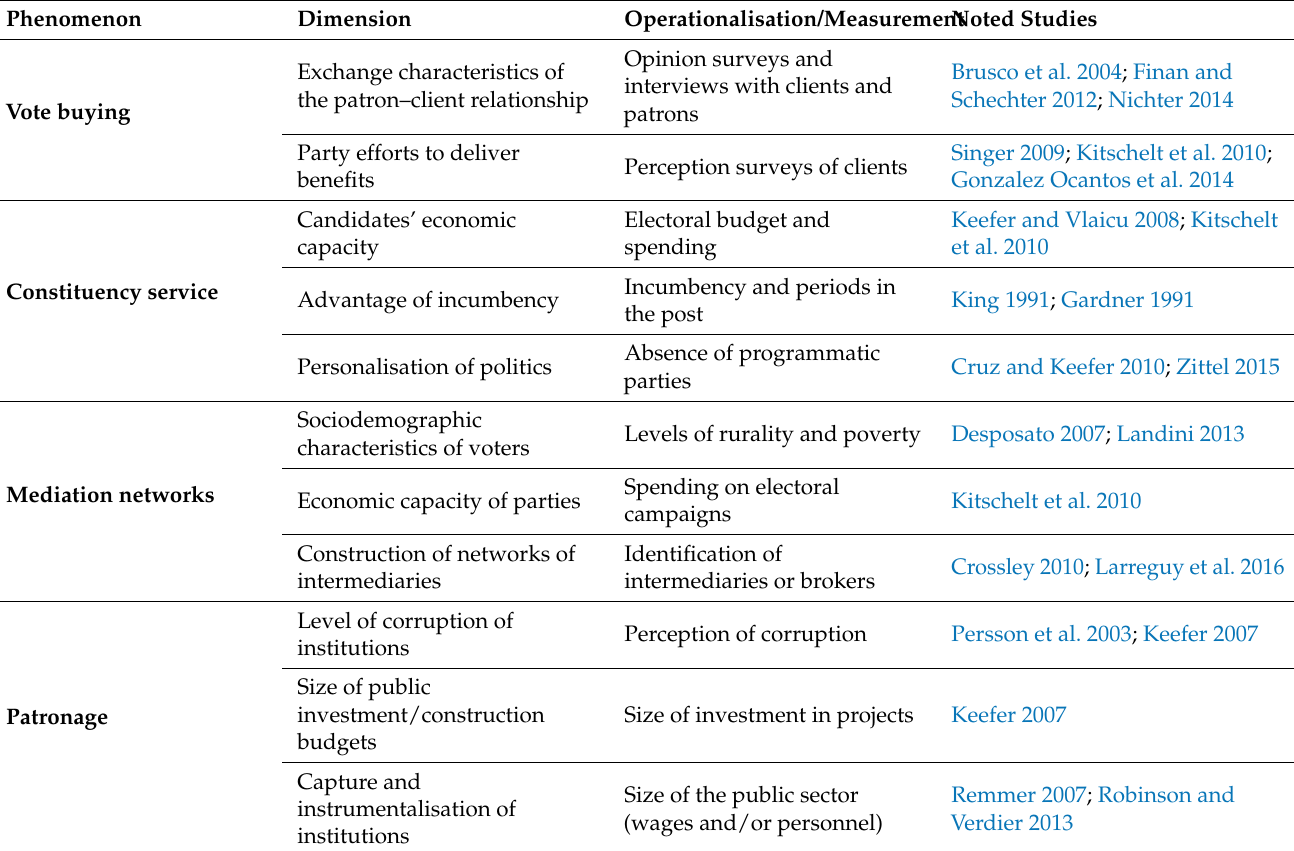
Table 1. Operationalisation of clientelism in the social